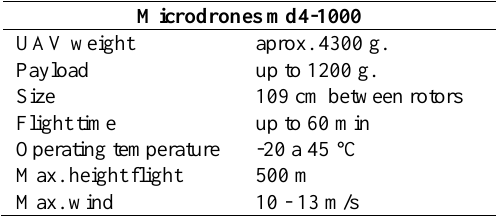
Table 1. Technical specifications of the UAV platform